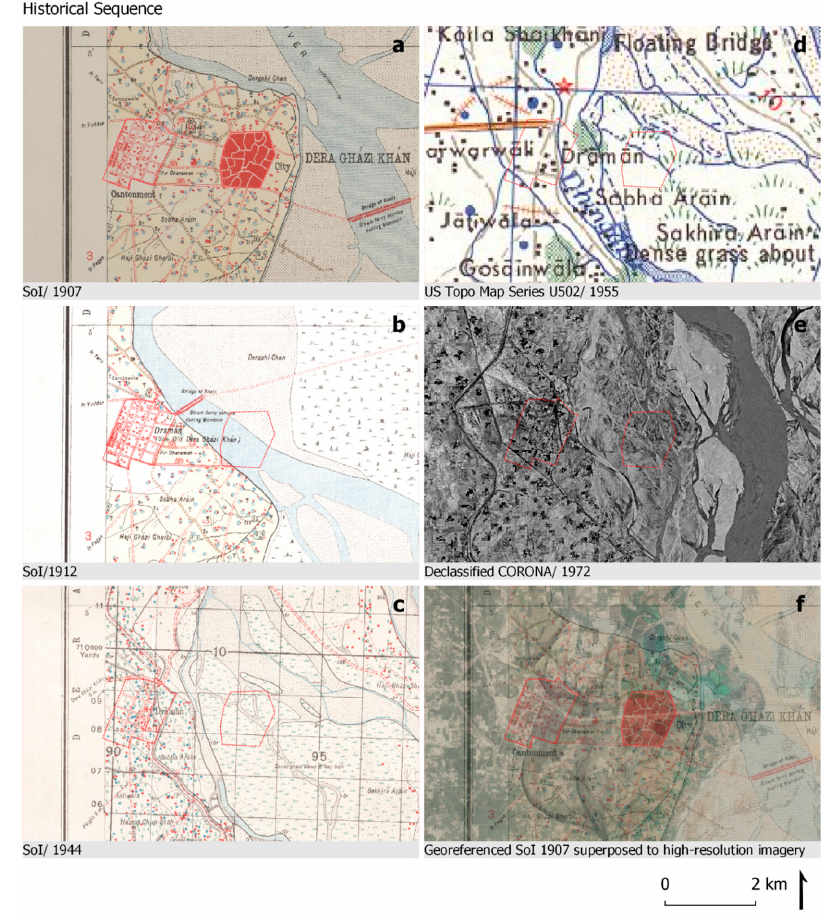
Figure 10. Detail of the area were DG Khan was placed until 1909 in different historical documents: SoI 1” to 1-mile, editions of ( a ) 1907, ( b ) 1912 and ( c ) 1944; ( d ) US Army Map Service, Series U502 of 1955; ( e ) declassified CORONA of 1972 and ( f ) present day high-resolution satellite image. SoI maps images courtesy of UL, Cambridge.